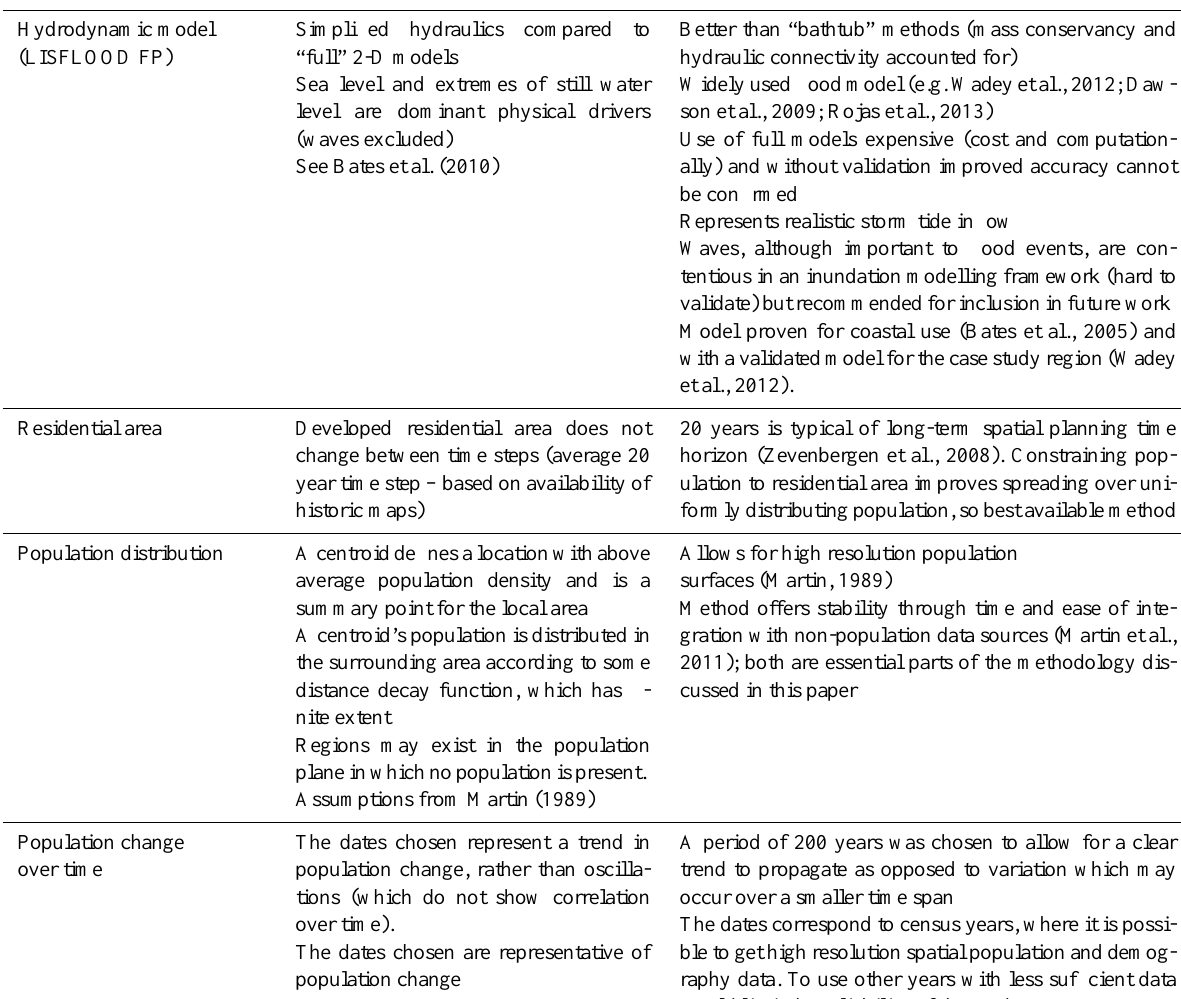
Table A1. Modelling Assumptions and justifications.